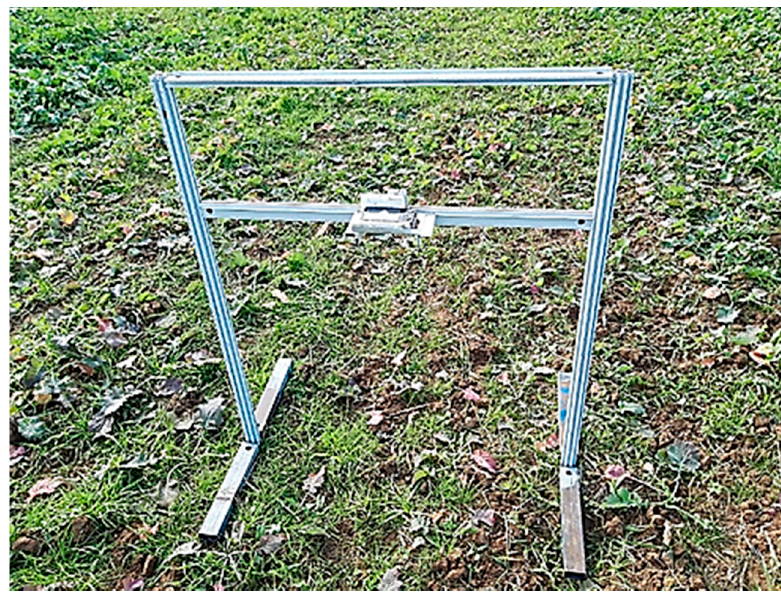
Figure 2. Platform for holding the camera and image acquisition.